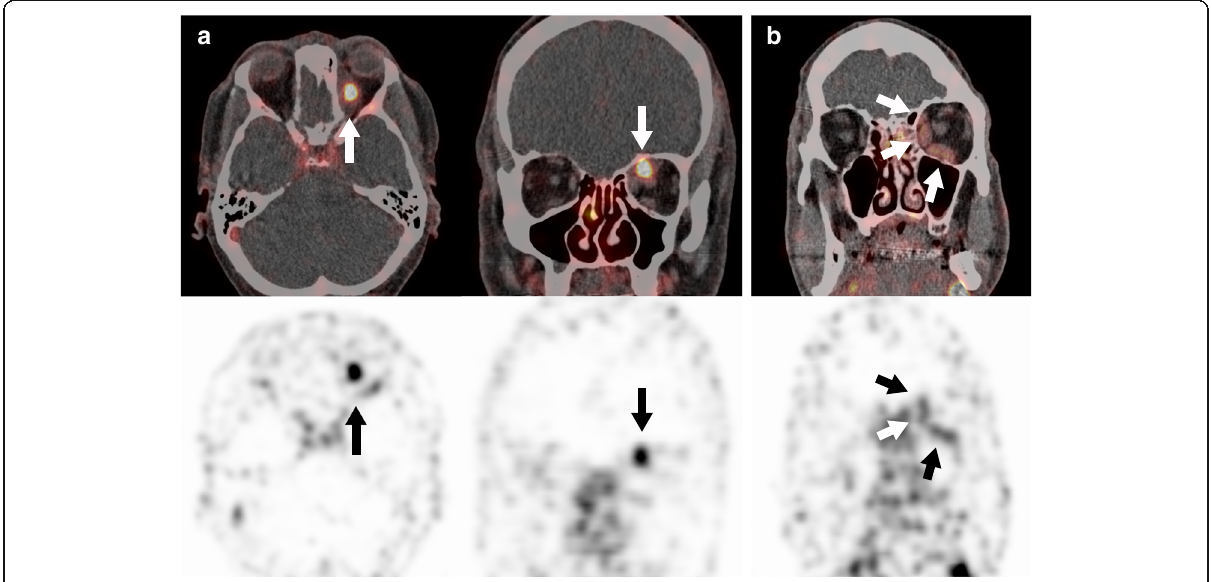
Fig. 1 Examples of 89Zr-rituximab PET/CT uptake. a Strong uptake in fusion image and PET-only image for the axial and coronal planes (arrows point at the lesion, SUVmax>2.0; case 6). b Moderate uptake in fusion image and PET-only image (arrows point at affected muscles, SUVmax 1.0 – 2.0, case